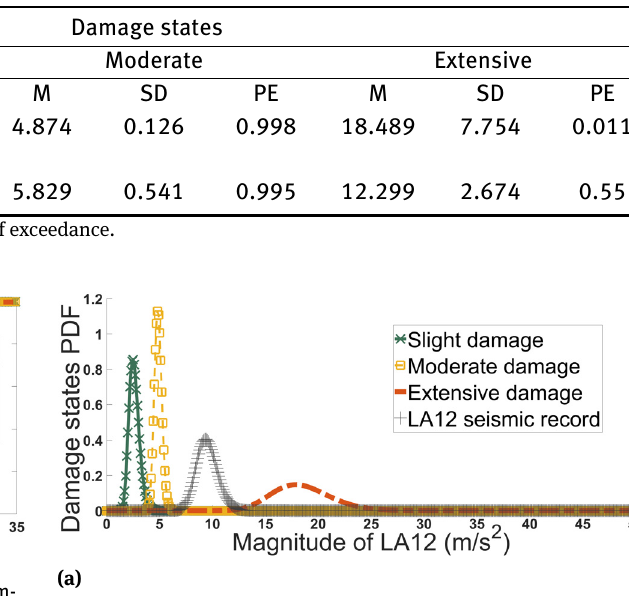
Figure 13: Fragility curves for slight, moderate and extensive dam- age state.